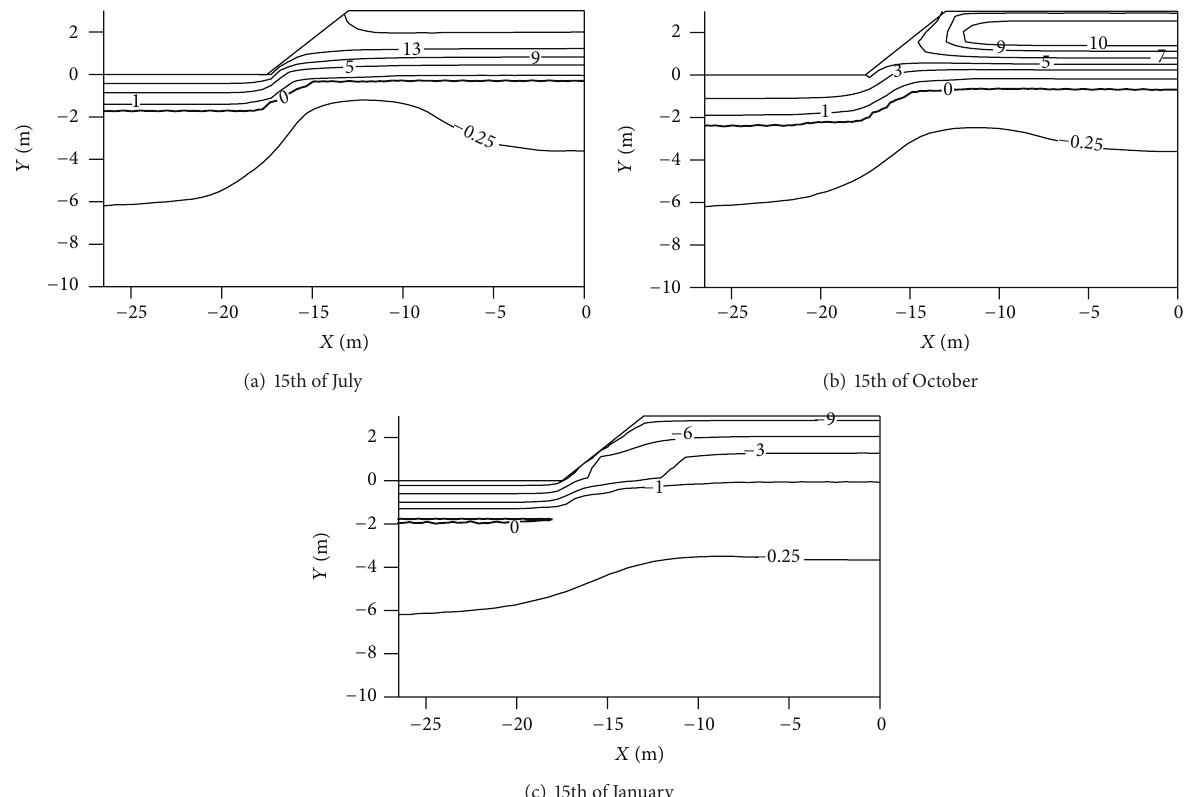
Figure 6: Temperature field of the closed crushed-rocks embankment with the wide pavement after 50 years of construction.